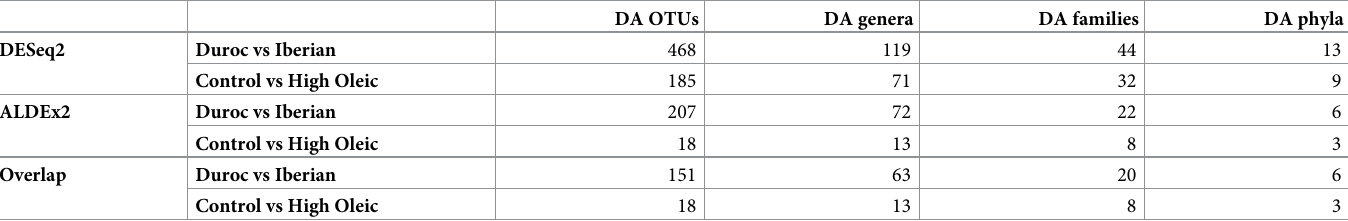
PERMANOVA did not show any significant association between overall microbiota composi- tion and the analysed phenotypic traits. When the effect of each individual OTU was evaluated Table 4. DA OTUs by factor and pipeline. DA OTUs DA genera DA families DA phyla DESeq2 Duroc vs Iberian 468 119 44 13 Control vs High Oleic 185 71 32 9 ALDEx2 Duroc vs Iberian 207 72 22 6 Control vs High Oleic 18 13 8 3 Overlap Duroc vs Iberian 151 63 20 6 Control vs High Oleic 18 13 8 3 Number of DA OTUs in breed and diet contrasts using DESeq2 or ALDEx2 pipelines, and common DA OTUs between both pipelines. Number of genera, families and phyla grouping these OTUs are also